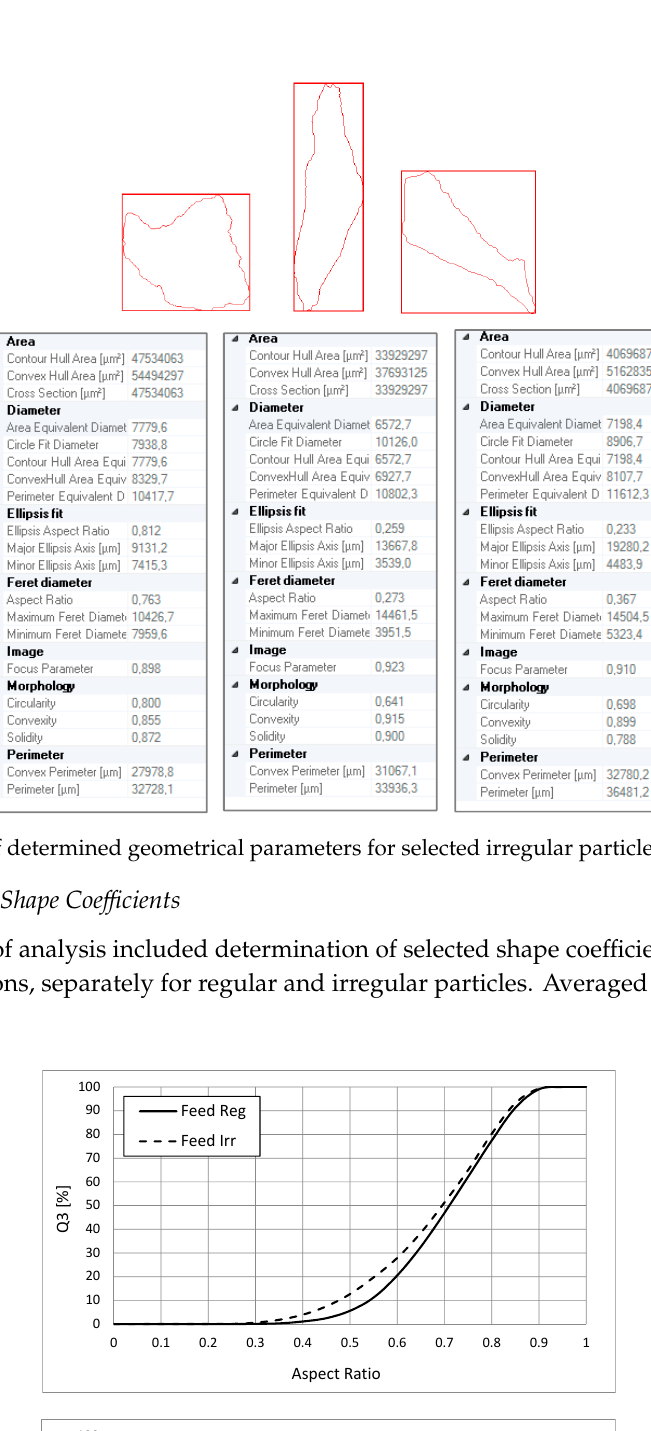
Figure 9. List of determined geometrical parameters for selected regular particles of chalcedonite.